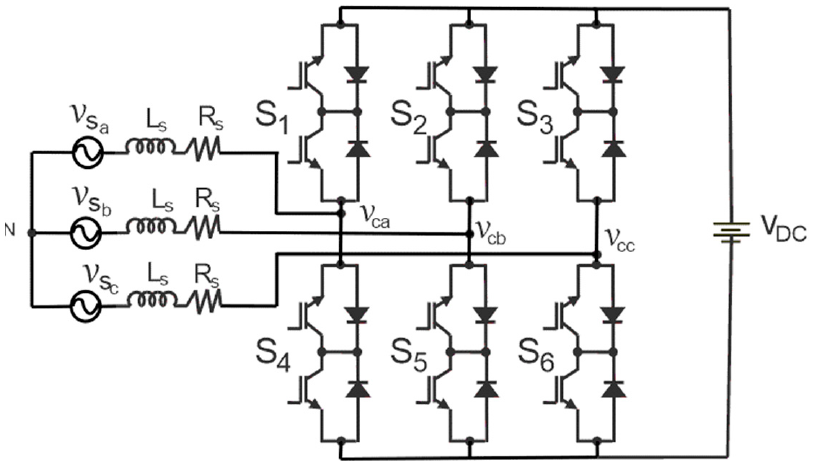
Figure 1. AC–DC converter to charge a battery.